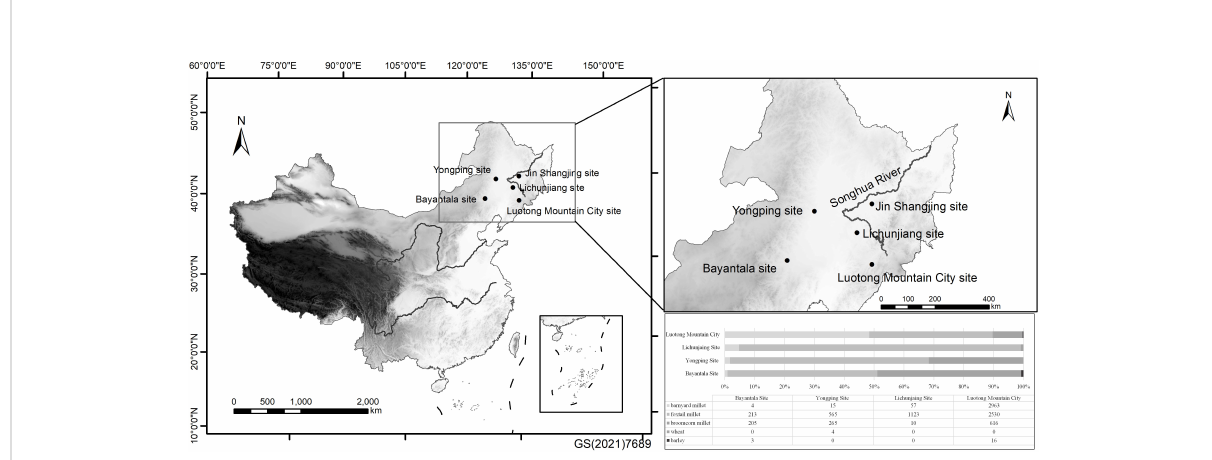
FIGURE 5 Geographical location and main crop proportions of archaeological sites of the Liaojin Dynasties in the SRR (a report on the fl otation plant remains from Jinshangjing site has not yet been published). (Original Image Source: